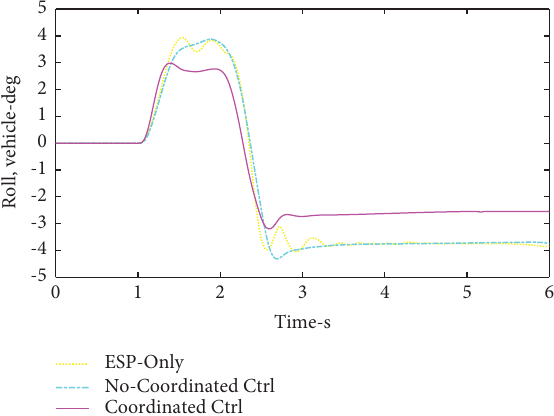
Figure 8: Variation curve of roll angle with time.